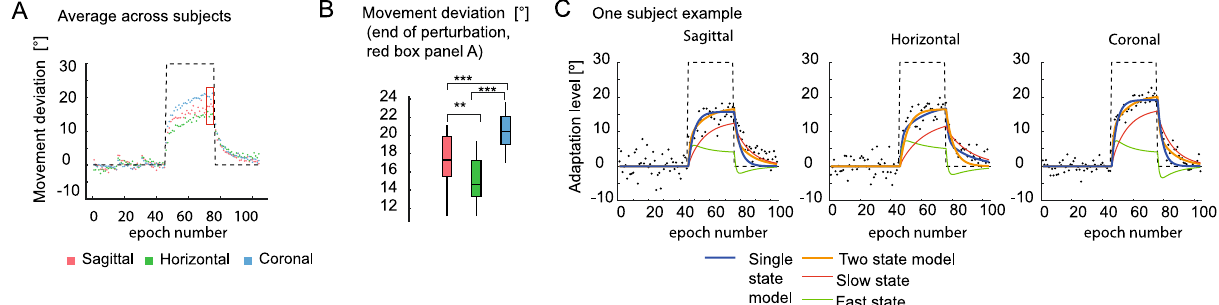
Figure 3. Visuomotor adaptation in three different planes relative to the body. ( A ) Averaged time course of adaptation across subjects for all perturbation planes. ( B ) Adaptation level reached at the end of the perturbation period for each plane (average of last four epochs, red box panel A ). ( C ) Examples of data fitted with a one-state and a two-states learning model, respectively. Black points represent the subject’s data (average movement angle at half-trajectory within 8-trial epochs; 105 epochs represent 360 concatenated baseline trials, 240 adaptation trials and 240 washout trials). The black dashed line shows the perturbation